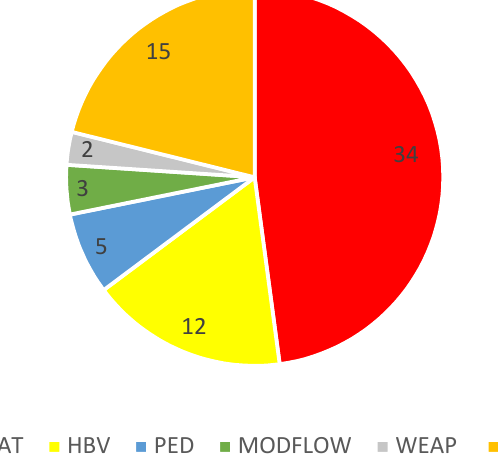
Figure 5. Types of hydrological models used in the Lake Tana Basin.